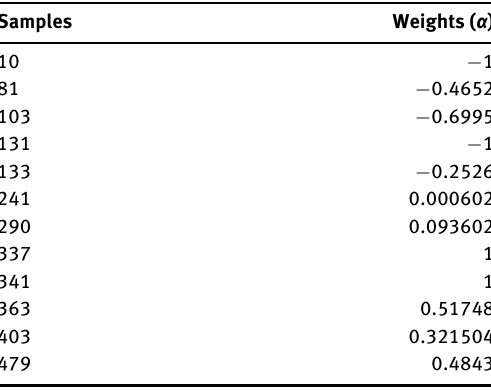
Table 5: Support Vector Points for Texture